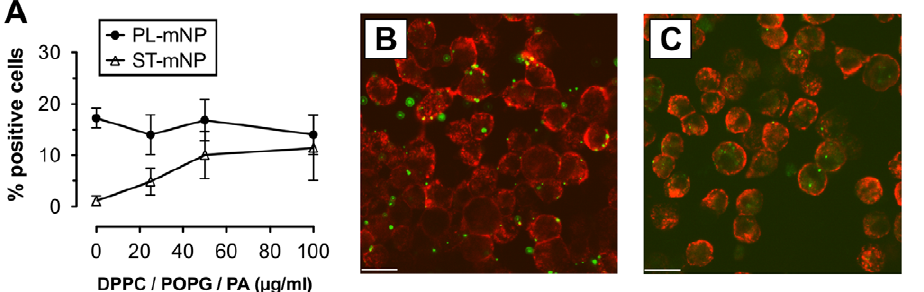
Figure 5. Effect of surfactant lipids on the association of nanoparticles with alveolar macrophages. (A) Starch- (ST) or Phosphatidylcholine-modified (PL) magnetite nanoparticles (mNP; 1.532 6 10 10 /ml) were incubated with alveolar macrophages (AM; MH-S cells) for 90 min in the absence or presence of 25, 50 or 100 m g/ml (total lipids) of surfactant-like membrane vesicles composed of dipalmitoyl-glycero- phosphocholine (DPPC), palmitoyl-oleoyl-glycero-phosphoglycerol (POPG) and palmitic acid (PA). Cells with Fl-1 . 10 1 were considered as positive cells for nanoparticle association and uptake (plotted as percent of positive cells with respect to total cells) compared to control (cells only). Data shown as mean 6 SD (n=6). Images are representative micrographs of AM (membrane in red) with ST-mNPs (B) or PL-mNPs (C) (in green), both in the presence of 100 m g/ml DPPC/POPG/PA. Scale bar indicates a distance of 20 m m.